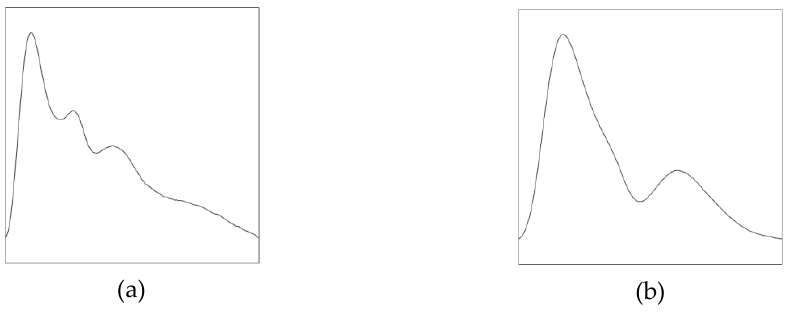
Figure 14. Typical pulse waveforms. ( a ) Normal pulse; ( b ) slippery pulse.